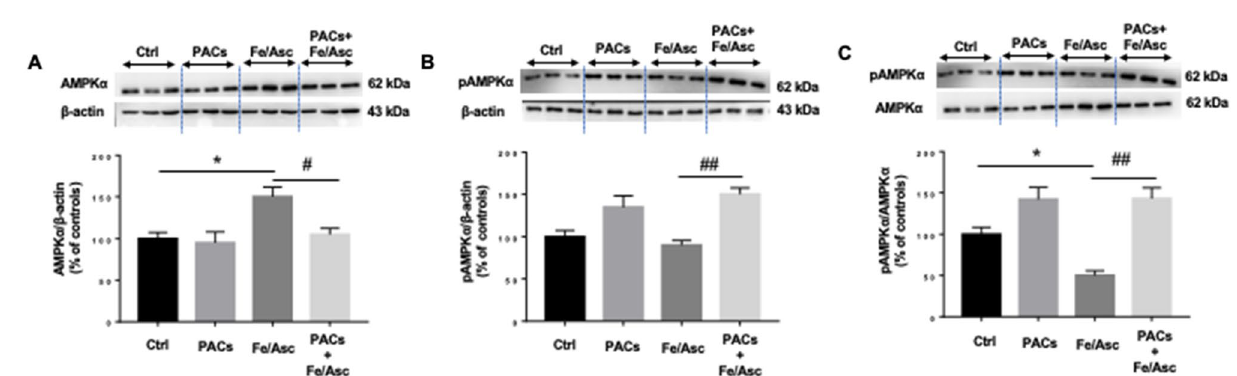
Figure 5. Effects of PACs on AMP-activated protein kinase alpha (AMPKα) regulating fatty acid β-oxidation and lipogenesis in Caco-2/15 cells. Proanthocyanidins (PACs, 250 µg/mL) were added to the apical cell compartment for 24 h prior to treatment with Fe/Asc (200 µM/2 mM) for 6 h at 37 °C. The protein expression of AMPKα was assessed by Western Blot. Results represent the means ± SEM of 3 independent experiments, each in triplicate. A representative Western blot is shown, illustrating an experiment in triplicate on the same gel and with the same exposure. *P < 0.05 vs untreated cells (ctrl). # P < 0.05, ## P < 0.01 vs Fe/Asc treated